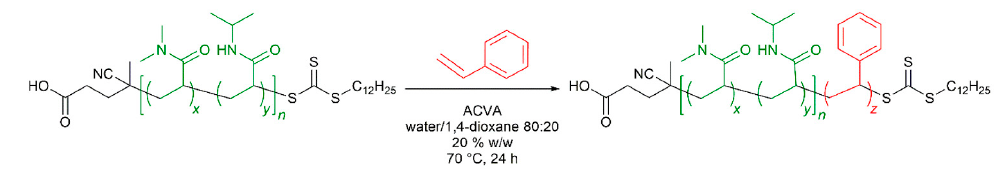
Figure 3. Synthetic route to poly(( N,N -dimethyl acrylamide)- co -( N -isopropyl acrylamide))- b - polystyrene (P(DMA- co -NIPAM)- b -PS) diblock copolymers via surfactant-free RAFT emulsion polymerization in water/1,4-dioxane 80:20 (20% w/w ).